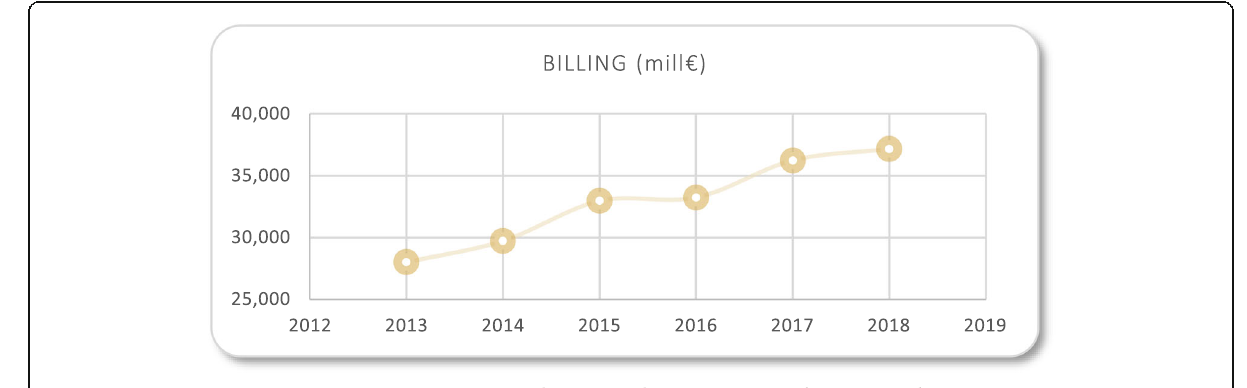
Fig. 7 Billing of the Spanish equipment industry